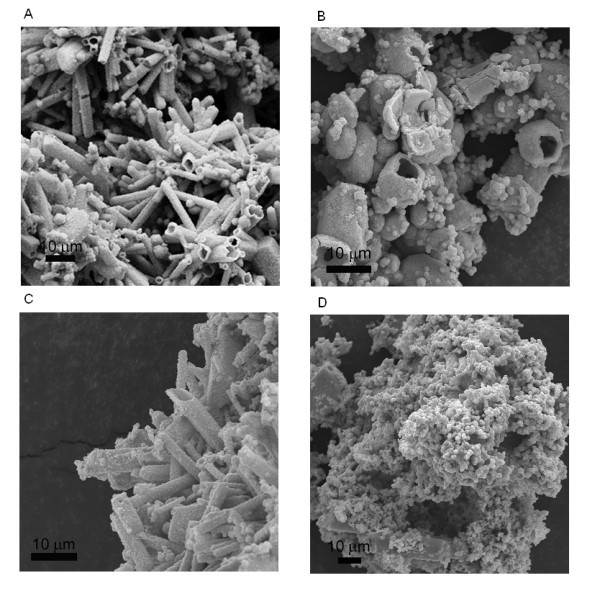
The FESEM images of ZnO nanostructures obtained at the  ratio of 3.2:1.0. (A) Zn(CH3COO)2·2H2O solution was added into (NH4)2CO3 solution, and (B) (NH4)2CO3 solution was added into the Zn(CH3COO)2·2H2O solution. (C) ZnSO4·7H2O solution was added into (NH4)2CO3 solution, and (D) (NH4)2CO3 solution was added into ZnSO4·7H2O solution.